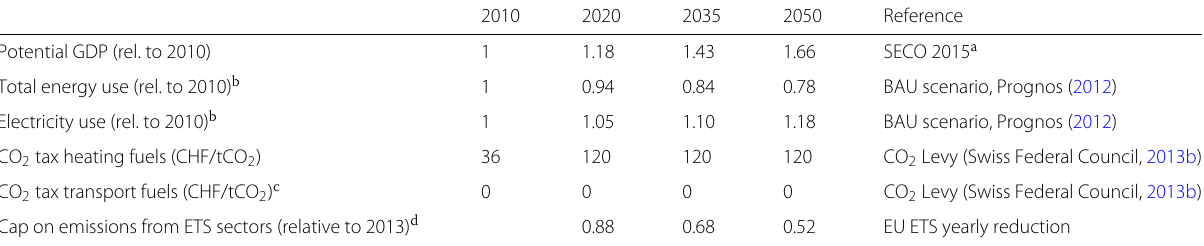
Table 5 BAU scenario: harmonizing